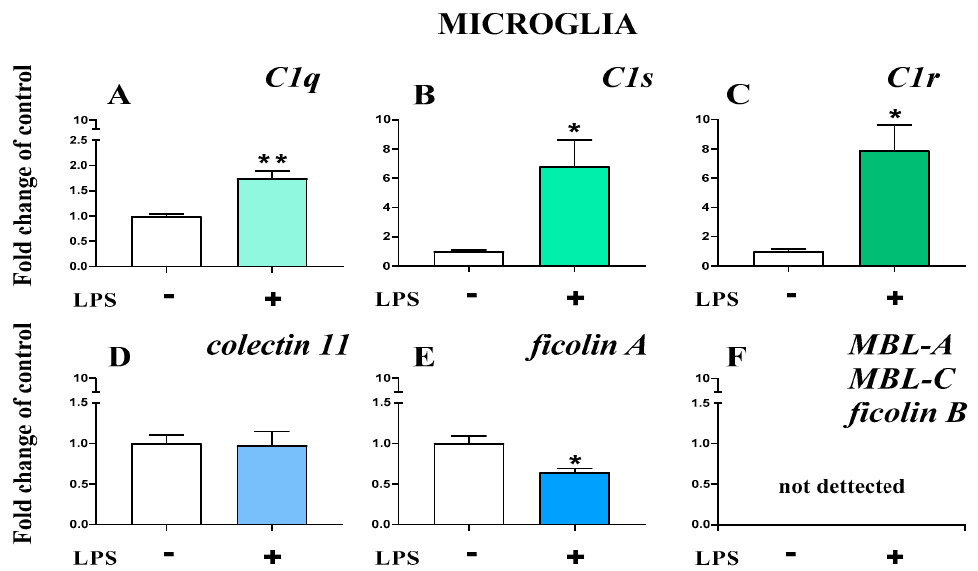
Figure 10. ( A – F ). The changes in initiators of classical pathway [green]: C1q, C1s, C1r; lectin pathway [blue]: mannose binding lectin A and C ( MBL-A , MBL-C ), collectin 11 , ficolin A , and ficolin B mRNA expression in primary microglial cultures. The data are the mean ± SEM ( n = 3). * p < 0.05; ** p < 0.01 indicate significant differences between non-stimulated (-) and LPS ‐ stimulated (+) cultures.